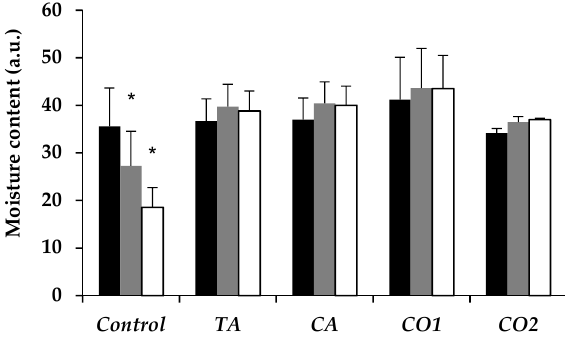
Figure 3 . Skin moisture content before application (■) , 15 min after application (■) , and 30 min after Figure 3. Skin moisture content before application ( (cid:4) ), 15 min after application (